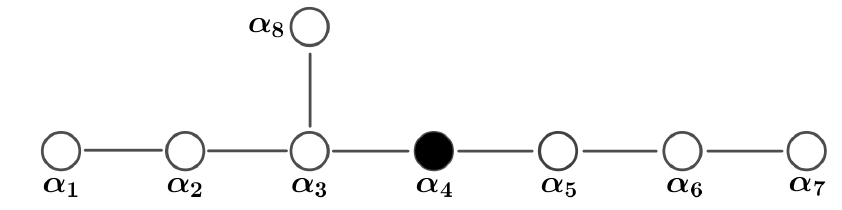
Figure 6 . E 8 Dynkin diagram, with the root blown up in the length five flop colored in